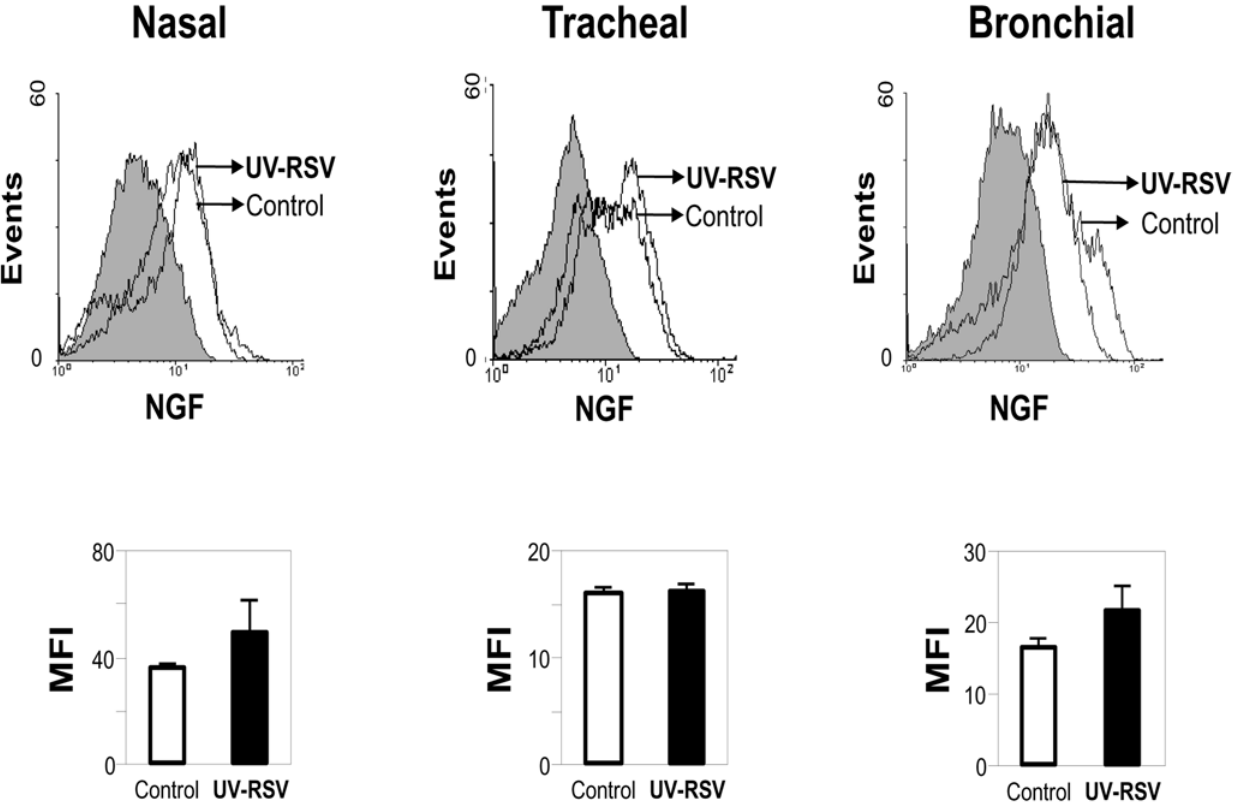
Figure 3. UV-inactivated RSV does not change NGF expression. (A) Following inactivation by UV light, rgRSV lost its effect on NGF expression in human airway epithelial cells. Changes in NGF protein expression were detected by staining UV-RSV-exposed or non-infected nasal, tracheal and bronchial epithelial cells with anti-human NGF antibody or a matched isotype control (shaded histogram). Primary antibody binding was detected by incubation with PE-conjugated goat anti-rabbit antibody. (B) Geometric mean fluorescent intensity (MFI) is presented in bar graphs. Data are expressed as the mean 6 SEM (n=4 experiments). None of the effects was statistically significant.